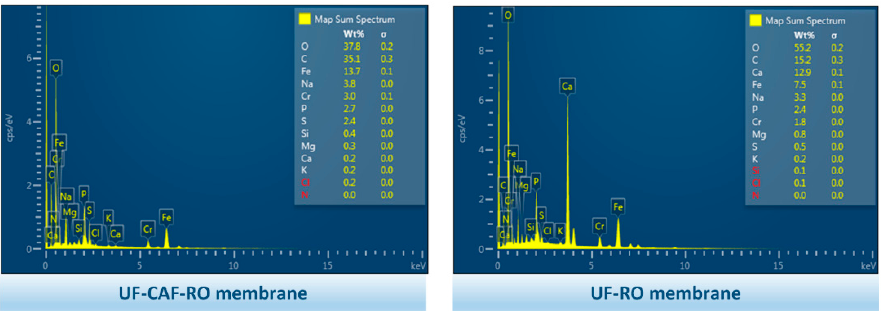
Figure 9. EDX analysis results of the fouled membrane surfaces from the 2nd evaluation (i.e., daily CAF backwash).